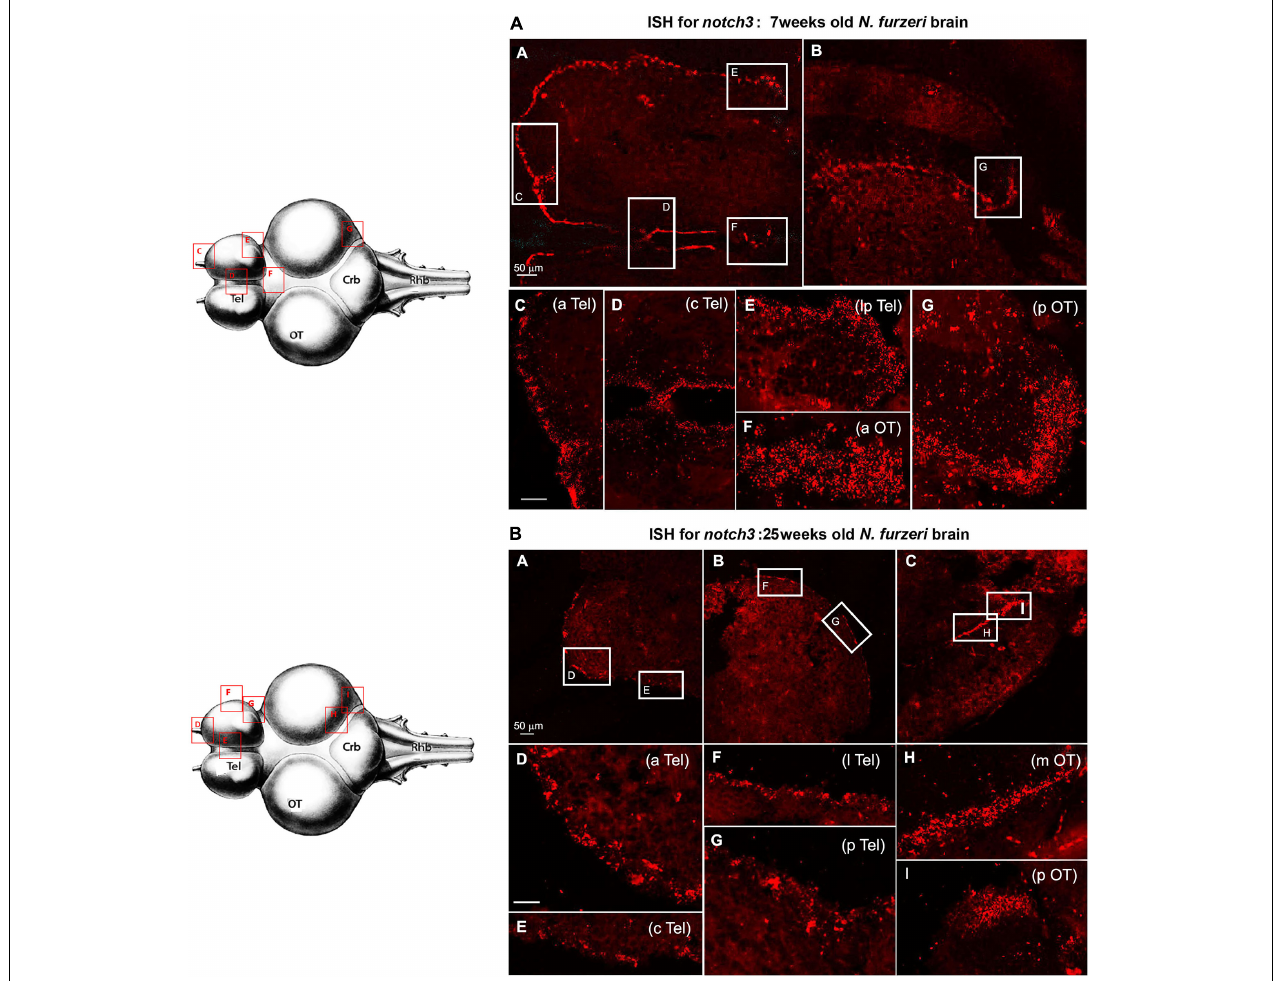
FIGURE 2 | Notch3 expression in proliferative niches of 7-weeks-old (A : A–G) vs. 25-weeks-old (B : A–F) N. furzeri brain . (A) (A,B) Overview of the brain in horizontal medial section (along the dorso/ventral axis) stained for notch1a , respectively, in telencephalon (A) and optic tectum (OT) (B) regions of a young N. furzeri brain (7 weeks). White frames show the areas magnified in panels (C–G), representing, respectively, the anterior (aTel), central (cTel), and lateroposterior (lpTel) telencephalic regions and the anterior (aOT) and posterior optic tectum regions. (B) (A–C) Overview of the brain in horizontal medial section (along the dorso/ventral axis) stained for notch3 , respectively, in the anterior (A) and lateroposterior (B) telencephalon and the posterior optic tectum (pOT) (C) regions of an old N. furzeri brain (25 weeks). White frames show the areas magnified in panels (D–I), representing, respectively, the anterior (aTel), central (cTel), lateral (lTel), and posterior (pTel) telencephalic regions and the anterior (aOT) and posterior (pOT) optic tectum regions. Scale bars always represent 50 µ m and are indicative for all further images without specific scale bar indication. Brain drawings on the left (modified from D’angelo, 2013–Atlas) represent the horizontal overview of the whole killifish brain; red-squared areas indicate the position of the figure panels based on the corresponding